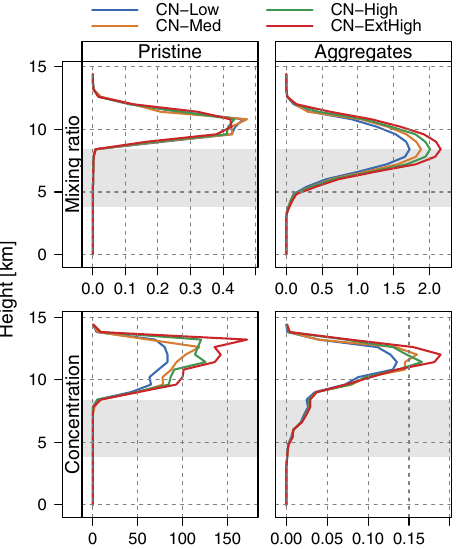
Figure 14. As in Fig. 12, but for pristine ice and aggregate cate-